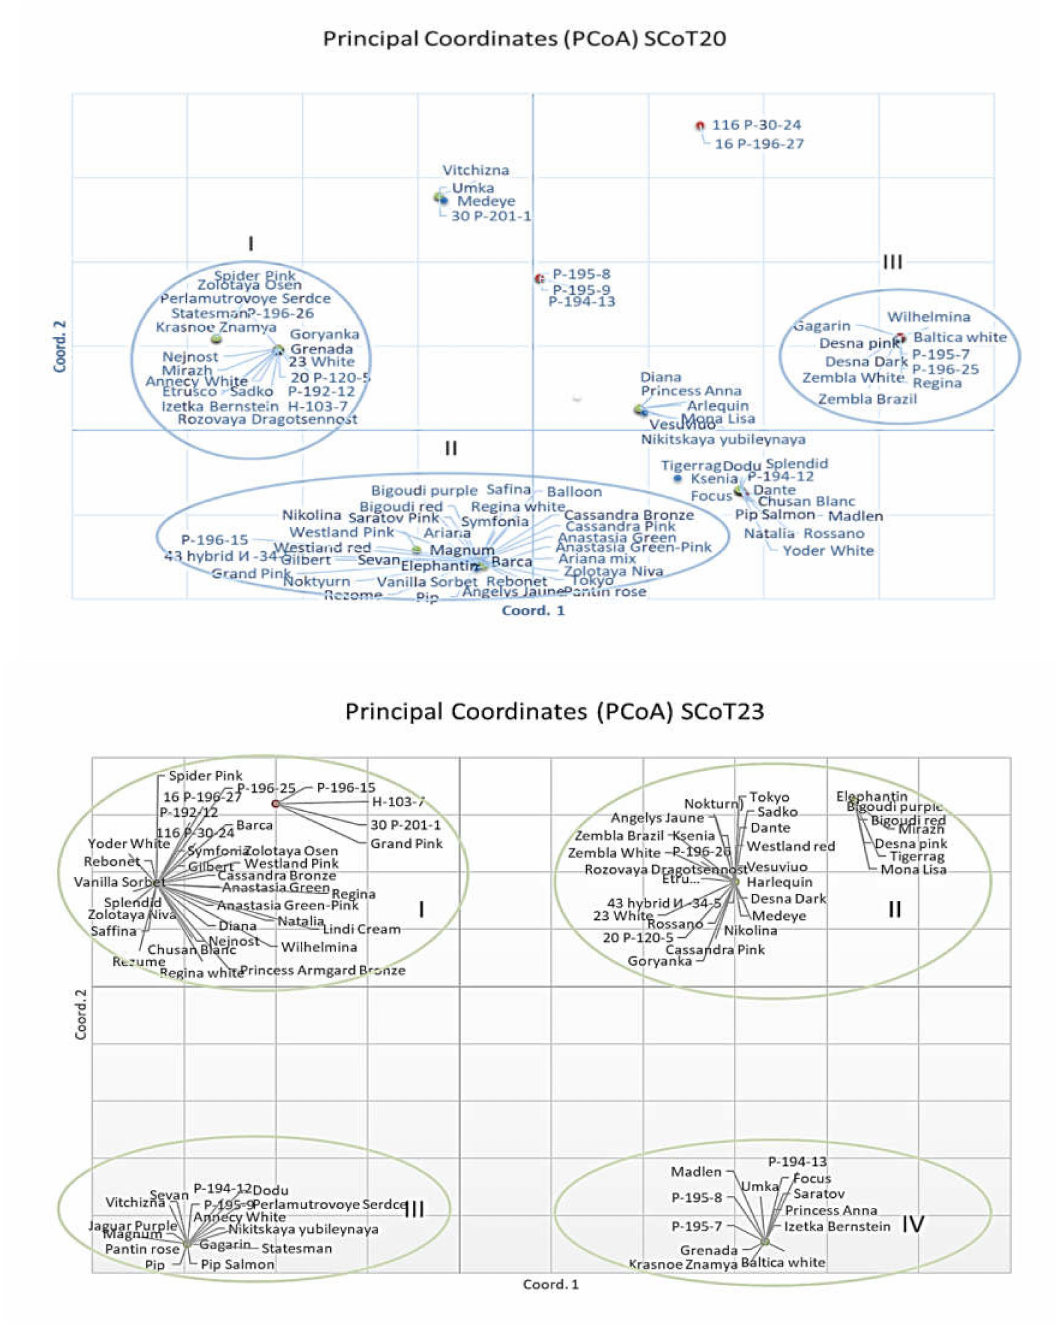
Figure 4. The genetic diversity among 95 chrysanthemum genotypes calculated by SCoT20 ( top ) and SCoT23 ( bottom ) markers. Different numbers indicate the main distant genetic clusters (I, II, III,